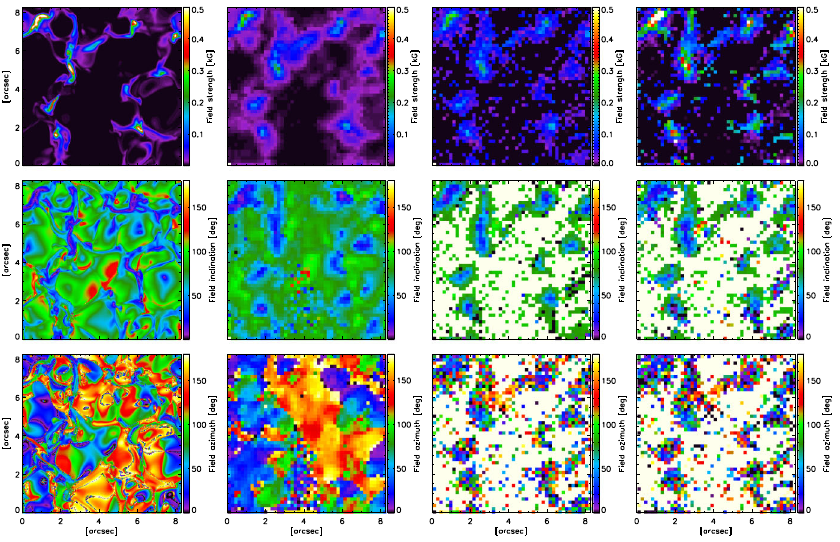
Fig. 8 Inversion of synthetic Stokes profiles from a magnetoconvection simulation representing quiet IN conditions. Maps of field strength, inclination, and azimuth are shown from top to bottom. The left column displays the original MHD model at log τ 500 = − 2. The other columns give the maps inferred from a one- component ME inversion of the synthetic profiles degraded spatially and spectrally without noise (second column), with noise of 10 − 3 I QS and α d = 0 (third column), and with noise of 10 − 3 I QS leaving the dilution factor as a free parameter (fourth column). Image reproduced with permission from Orozco Suárez et al. (2007a), copyright by